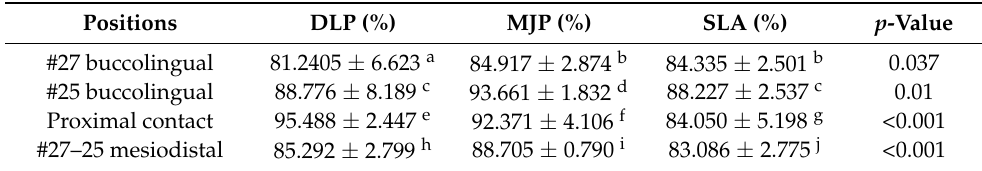
Table 3. The inTOL (%) of trueness (mean ± SD) for 3D-printed models ( n = 36). Positions DLP (%) MJP